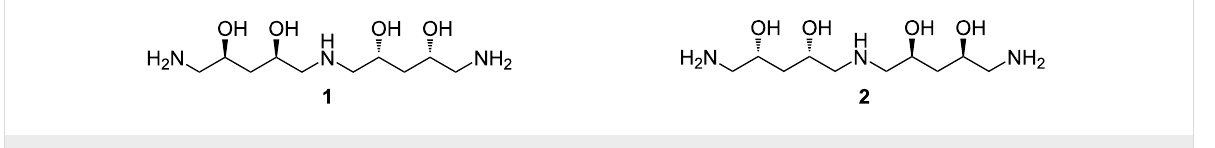
Figure 1: Structure of pavettamine 1 and its enantiomer 2 .